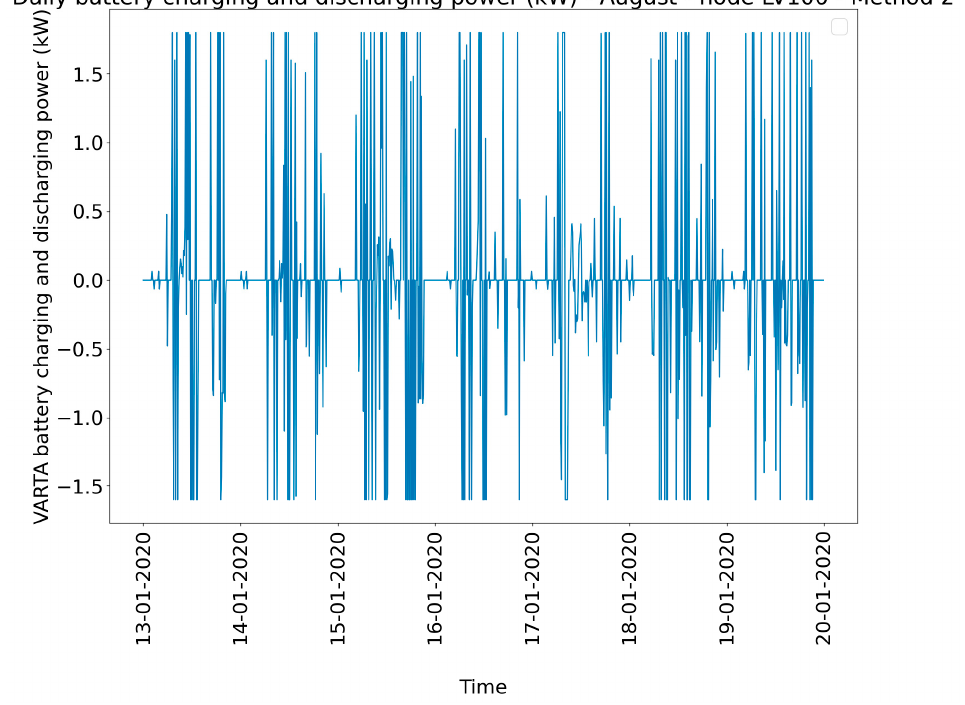
Figure A6. VARTA battery charging and discharging curve—August—Method 1.